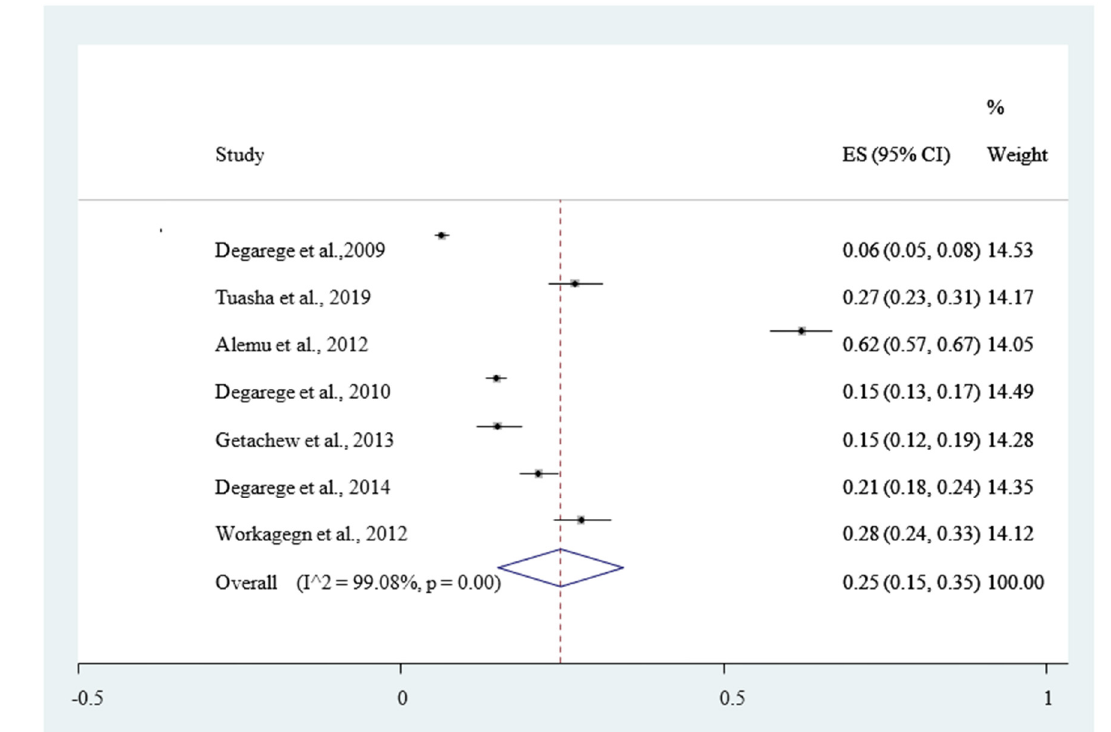
Figure 7. Forest plot of 6 studies on magnitude of Hookworm infection among outpatients in Ethiopia, 2020.